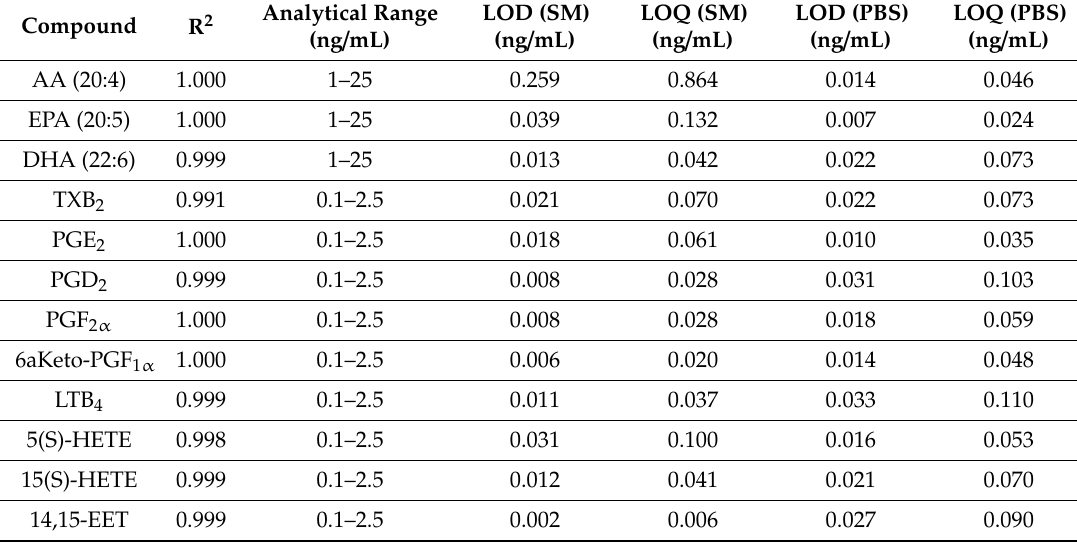
Table 2. Calibration parameters for PUFAs / eicosanoids